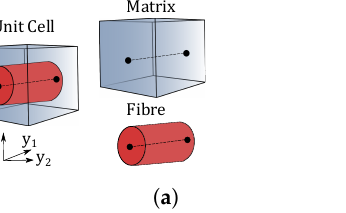
Figure 5. ( a ) Component-wise modelling of composite microstructure with different phases. ( b ) Kine- matics used to define the RUC